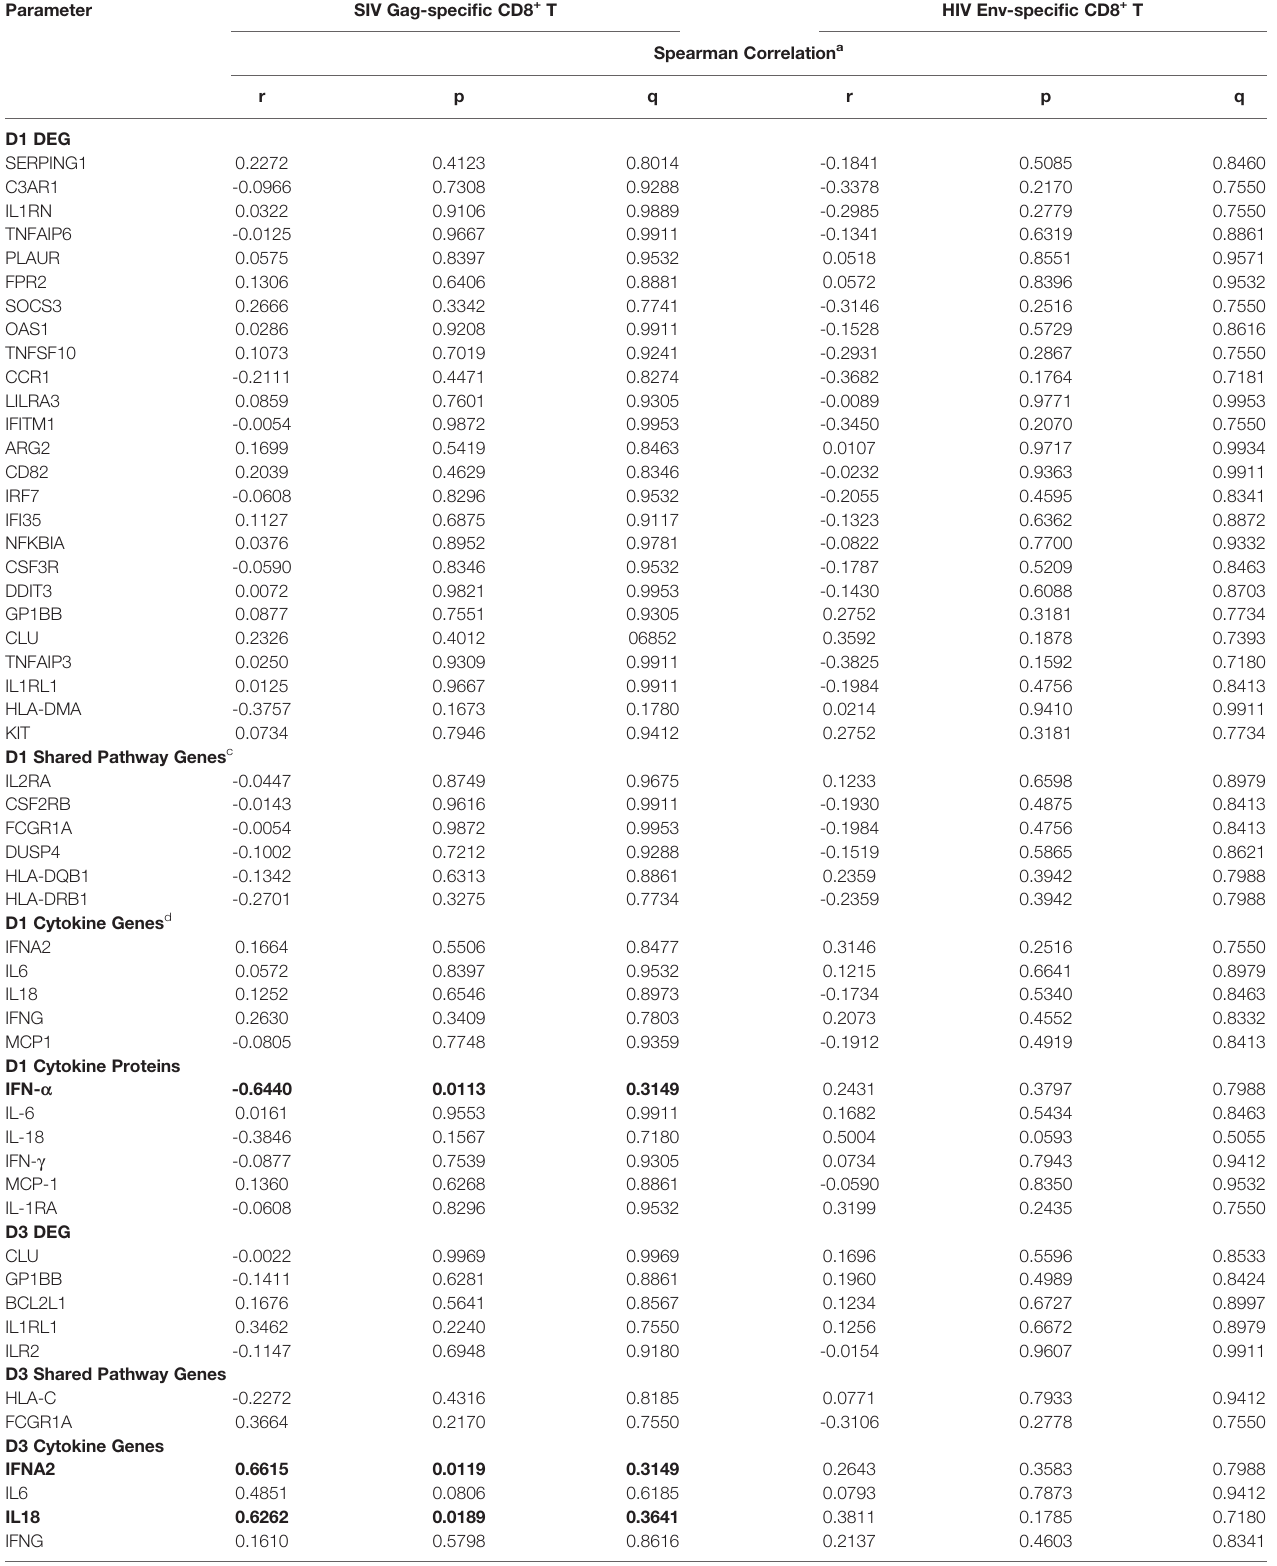
TABLE 6 | Correlation of early gene expression with antigen-speci fi c CD8 + T cell responses.